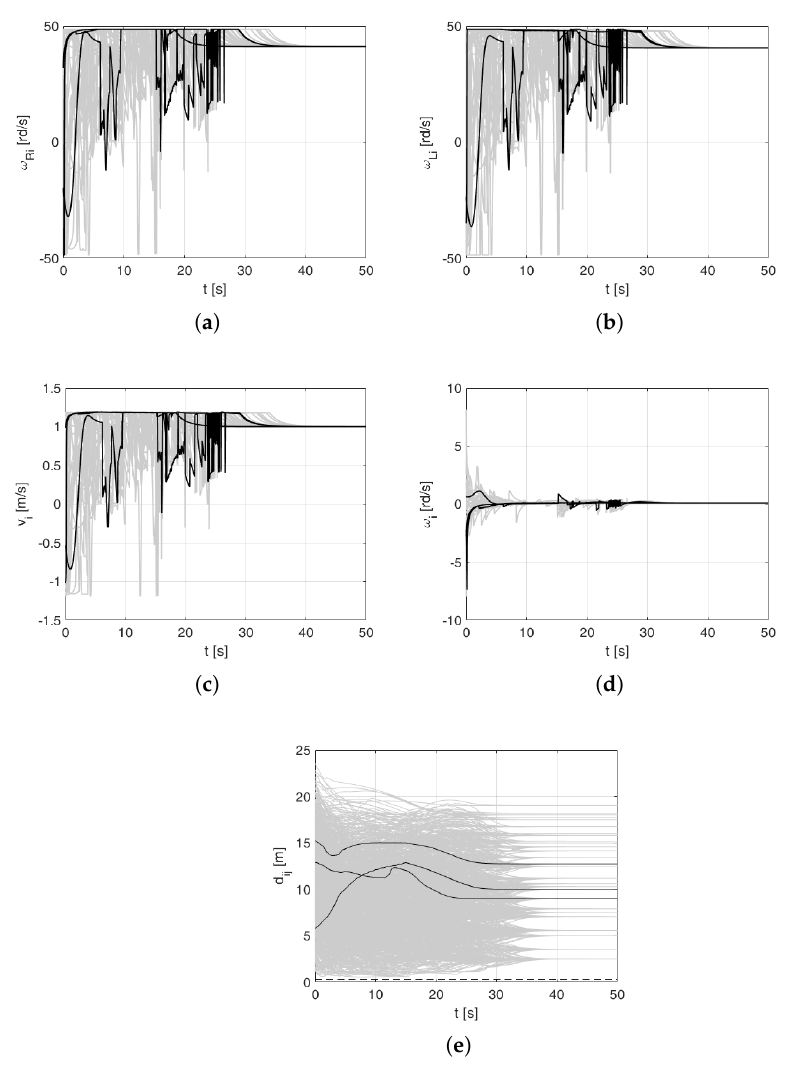
Figure 13. Numerical simulation 3: trajectory tracking for N = 48 robots with goal exchange and saturated wheel controls. ( a ) right wheel velocities, ( b ) left wheel velocities, ( c ) linear velocity controls, ( d ) angular velocity controls, ( e ) distances between